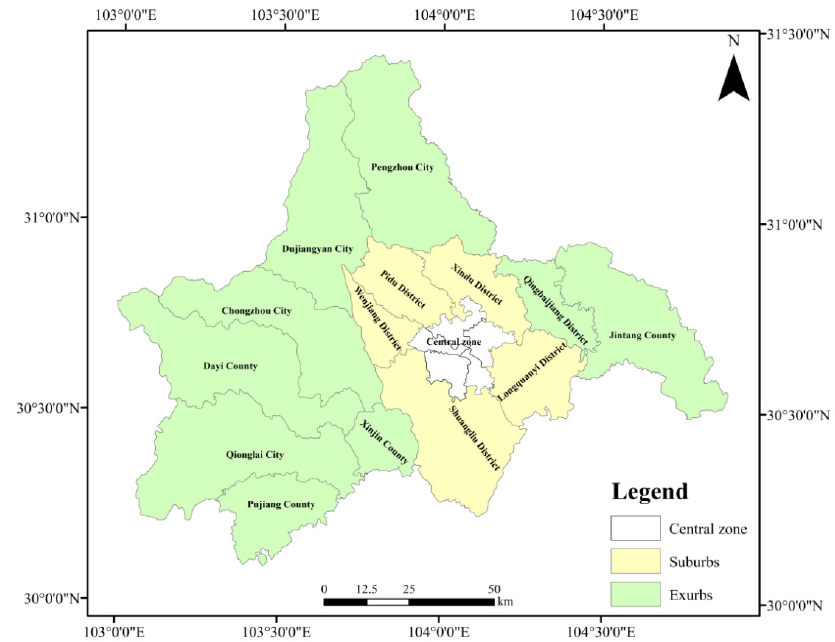
Figure 1. County districts in the suburbs and exurbs of Chengdu.